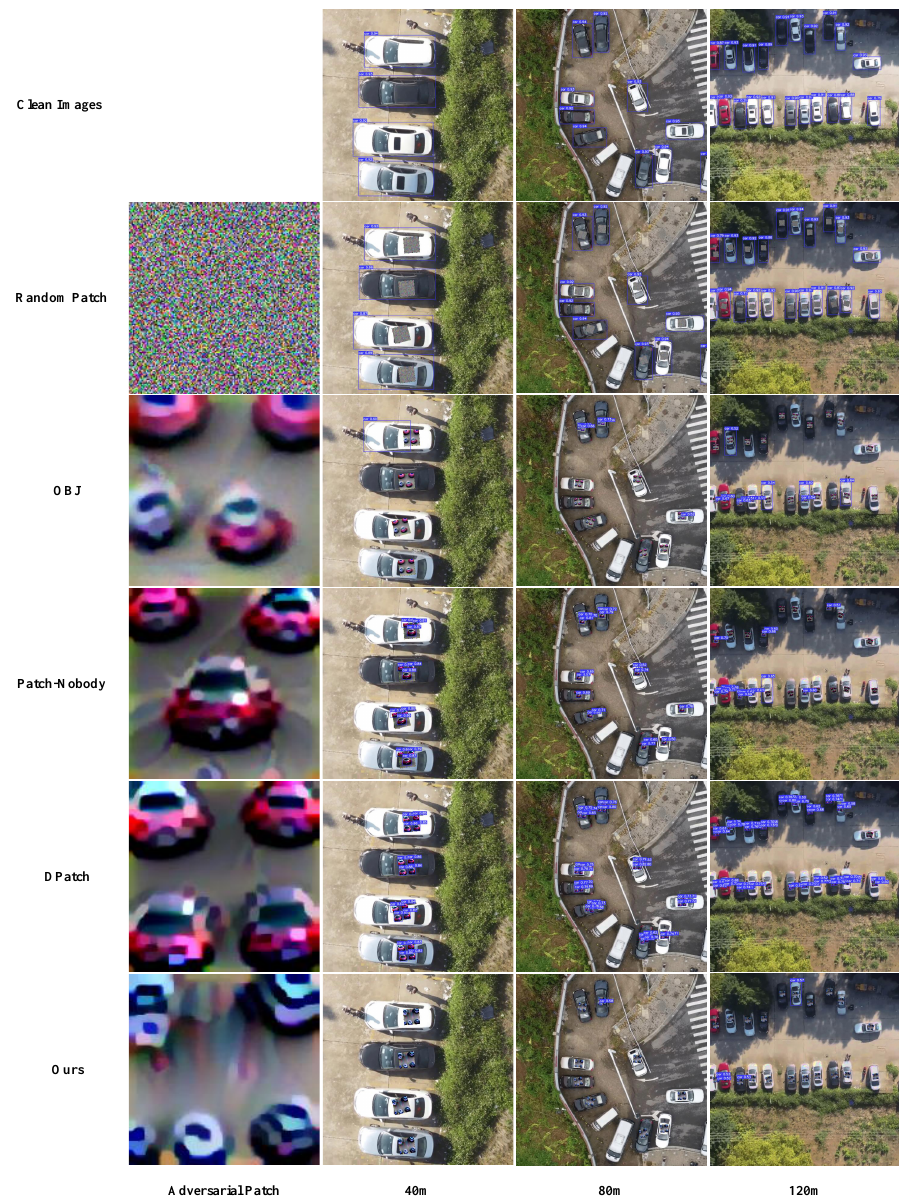
Figure 6. Comparison of the attack effects for our method, Dpatch, OBJ, Patch-Noobj and random patch for Yolo-V5. Images shown in this figure were captured at heights of 30 m, 60 m and 90